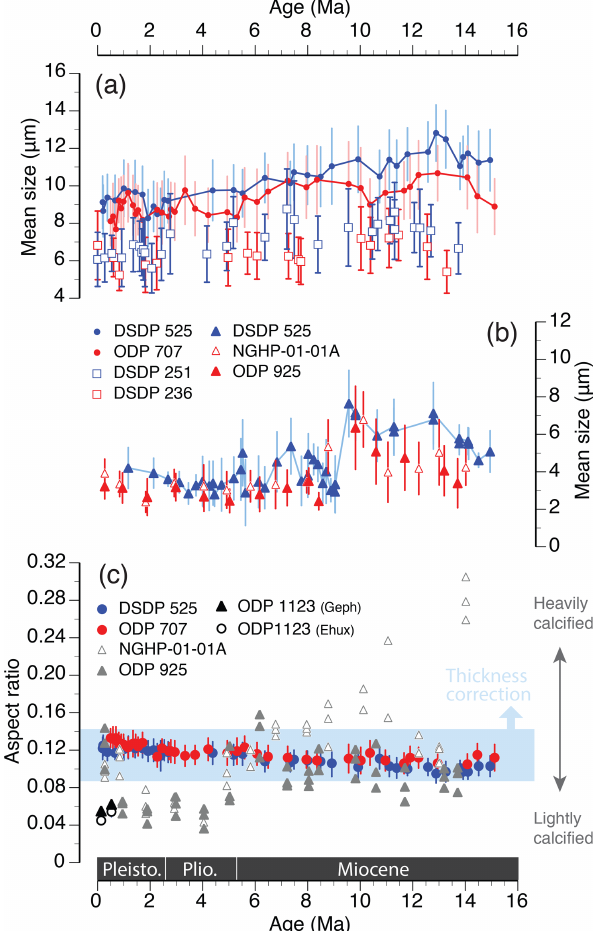
Figure 7. Comparison of macroevolutionary phenotypic trends in three prominent coccolithophore lineages at temperate (blue) and tropical (red) sites, over the past 15Myr. Mean coccolith size (length; µm) of (a) Helicosphaera (dots; this study) and Calcidis- cus (open squares; Knappertsbusch, 2000) and (b) Reticulofenestra (triangles; this study in blue; Bolton et al., 2016, in red). Error bars are ± 1SD. (c) Mean aspect ratio (AR) in fossil specimens of Heli- cosphaera (blue and red dots; as in Fig. 4b) compared to AR esti- mates in Reticulofenestra spp. (grey triangles; grouped within size ranges of 2–3, 3–4, and 4–5µm; Bolton et al., 2016), Emiliania and Gephyrocapsa (black symbols; McClelland et al., 2016). The light- blue shading encompasses the 1SD variation in Helicosphaera over the entire time interval, whereas the long-term average AR would shift upwards if corrected for the systematic underestimation of thickness, as discussed in Sect.